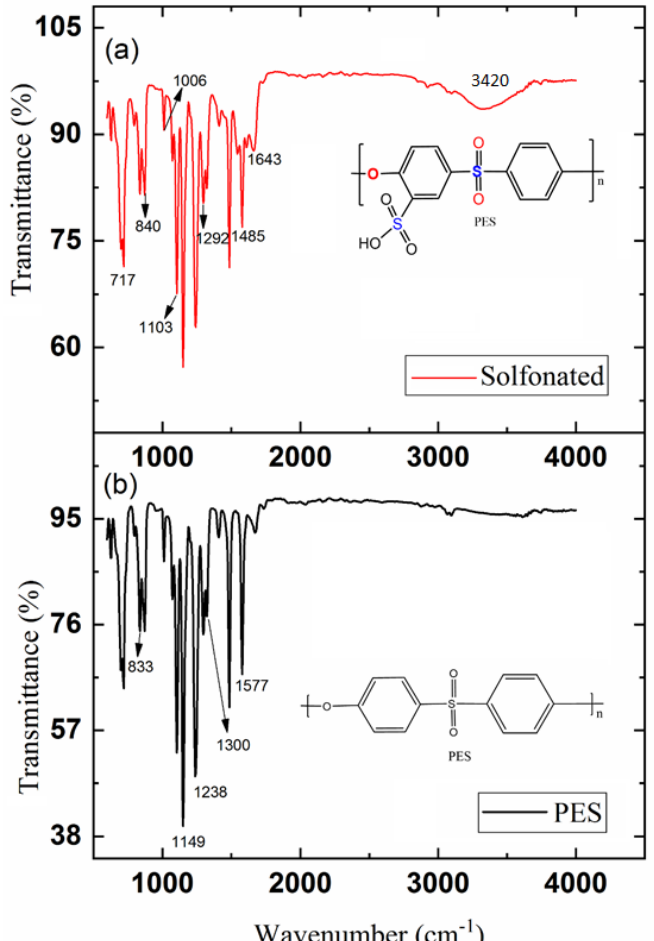
Figure 5. Fourier transform infrared ( FTIR) spectra of the membrane substrates for ( a ) SPES (T 3 ), and ( b ) PES (T 1 ) samples. ( b ) PES (T 1 )